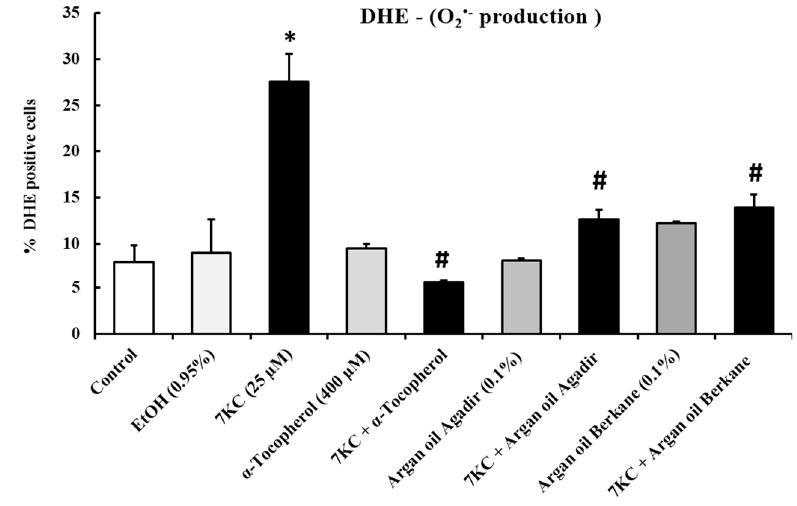
Figure 2. Evaluation of the effect of argan oil on 7-ketocholesterol-induced overproduction of reactive oxygen species in 158N murine oligodendrocytes by flow cytometry after staining with dihydroethidine. After 24 h of culture, 158N murine oligodendrocytes were cultured for an additional 24 h without or with 7KC (25 µM) in the absence or presence of argan oils (Agadir or Berkane; Morocco; 0.1% v / v ) or α -tocopherol (400 µM) used as the positive control. Argan oils and α -tocopherol were added to the culture medium 2 h before 7KC. The cytoprotective effect of argan oils on 7KC-induced overproduction of reactive oxygen species (ROS), mainly superoxide anions, was evaluated by flow cytometry after staining with dihydroethidine (DHE). ROS overproduction was determined by the percentage of DHE-positive cells. The experiments were carried out twice in triplicate. Data are mean ± SD of two independent experiments carried out in triplicate. The significance of the relationship between vehicle and cells treated with 7KC, argan oils or α -tocopherol was calculated by the Anova test (Sidak’s multiple comparisons); * p ≤ 0.05. The significance of the relationship between cells treated with 7KC alone, 7KC and argan oils cotreatment, or 7KC and α -tocopherol cotreatment was calculated by the Anova test (Sidak’s multiple comparisons); # p ≤ 0.05. No significant difference between control and vehicle-treated cells (EtOH 0.95% v / v